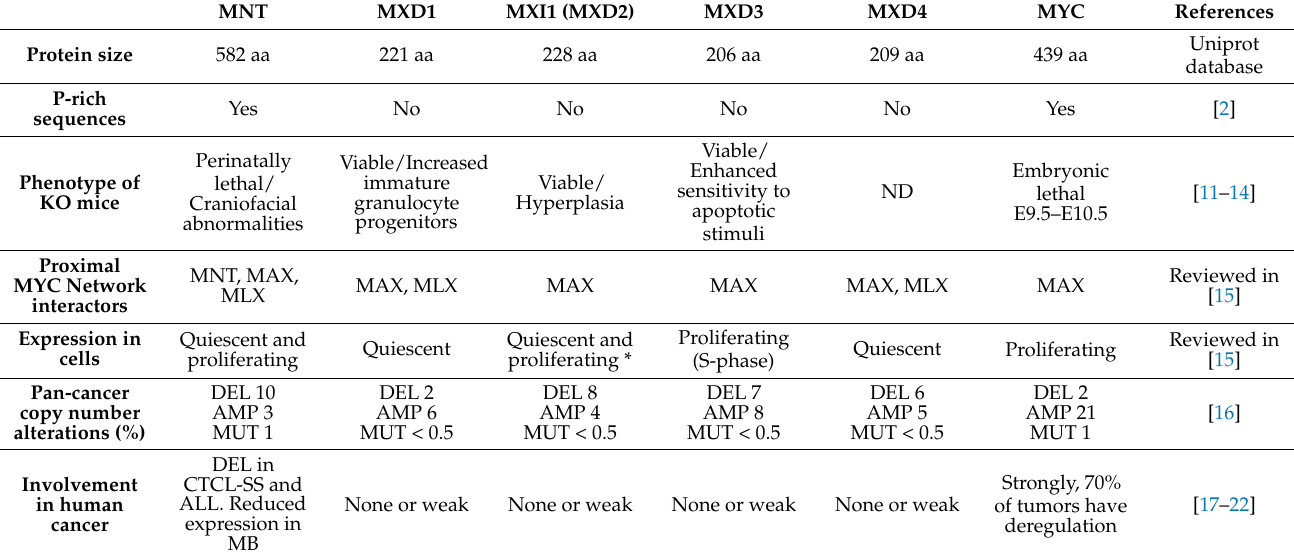
Table 1. Main differences between the human MNT, other human MXD proteins, MGA, and MYC. The sizes of the proteins are the largest canonical forms, according to the UniProt database. Aa, amino acids; ND, not done; DEL, deletions; AMP, amplifications; MUT, mutations; CTCL, Cutaneous T-cell lymphoma; MB, medulloblastoma; SS, Sezary Syndrome; ALL, acute lymphoblastic leukemia. MNT